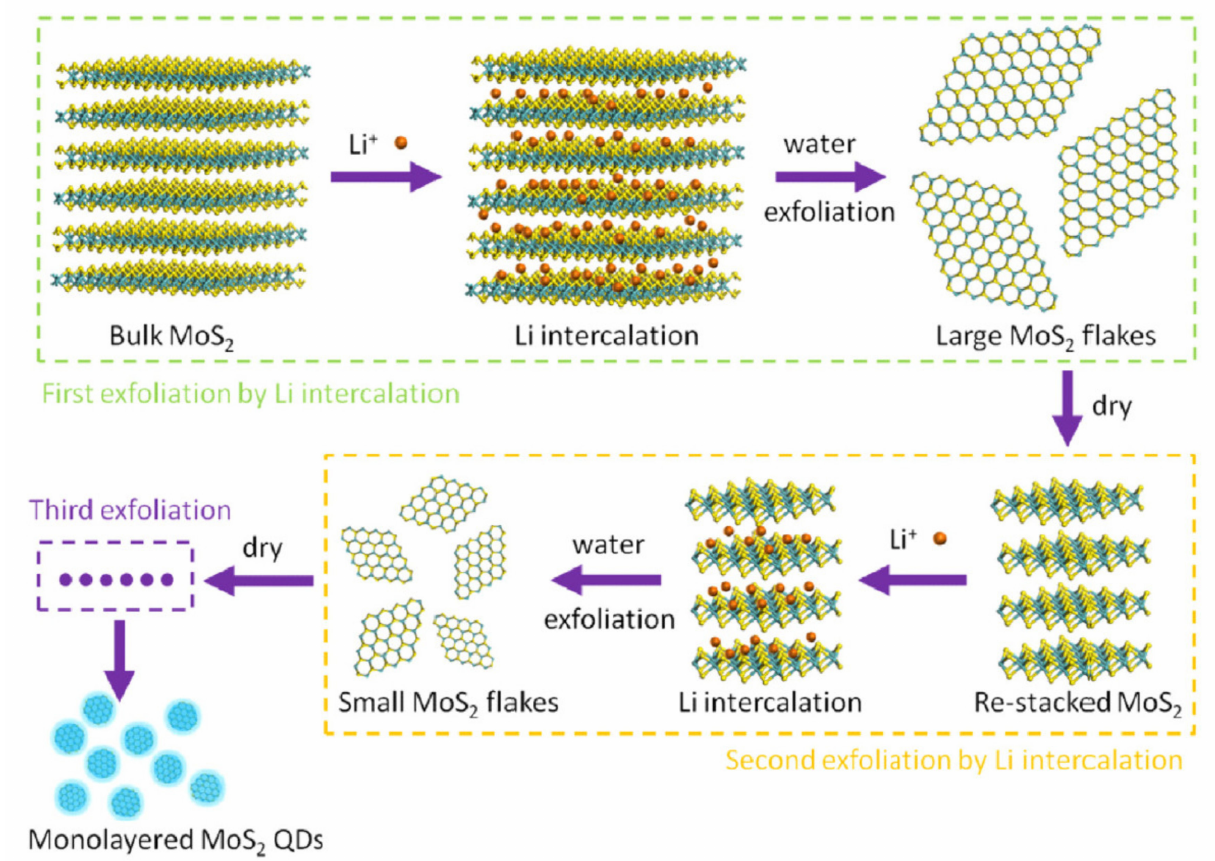
Figure 7. Schematic illustration of the preparation of monolayer MoS 2 QDs using multiple exfoliation with Li intercala- tion [78]. Figure reproduced with permission from